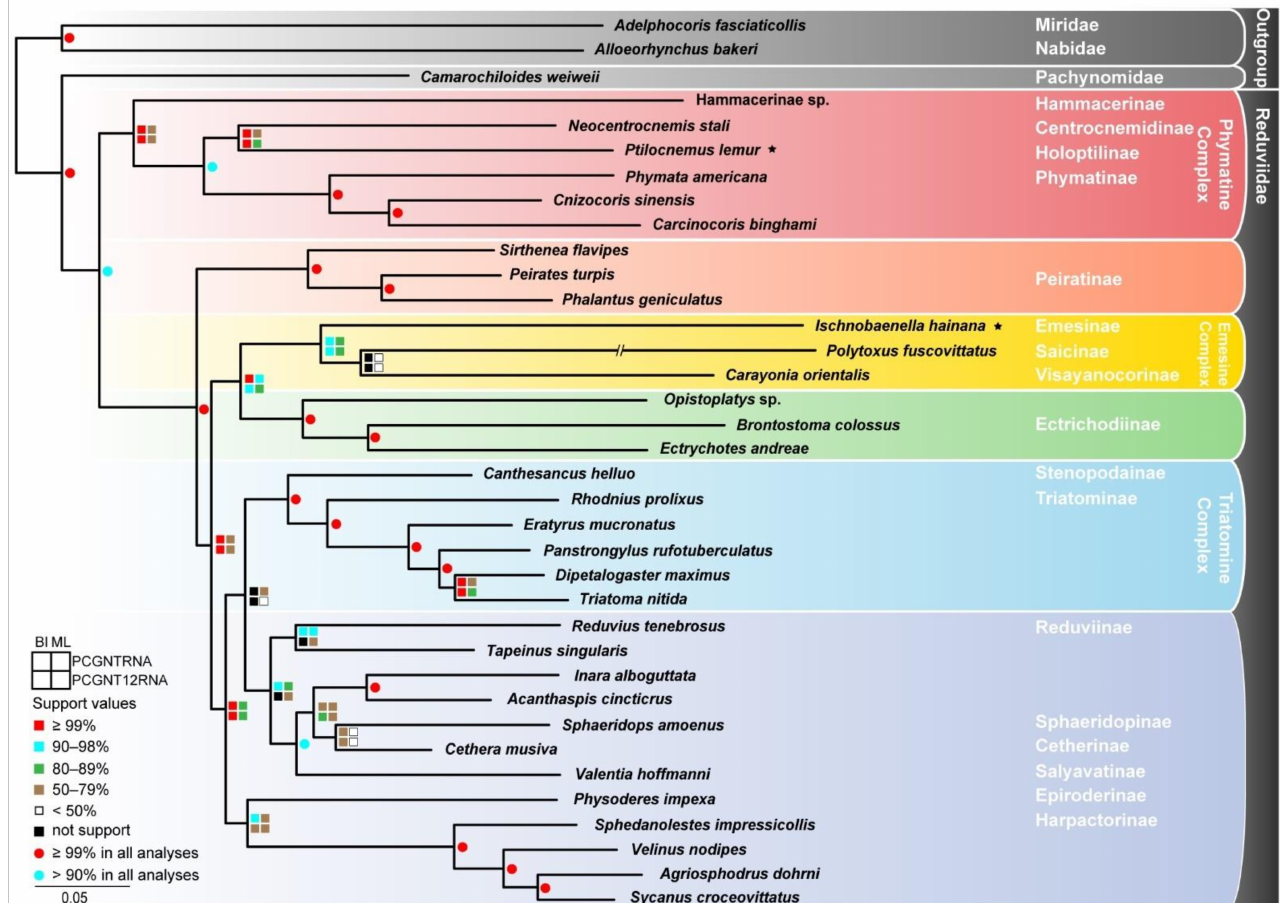
Figure 2. Phylogenetic tree of Reduviidae inferred from maximum-likelihood analyses based on PCGNTRNA and PCGNT12RNA datasets concatenated four rDNAs and 13 mitochondrial PCGs. Bootstrap values of maximum-likelihood analyses and posterior probabilities values of Bayesian analyses are labeled around each node. Asterisks denote new mitogenomes generated in this